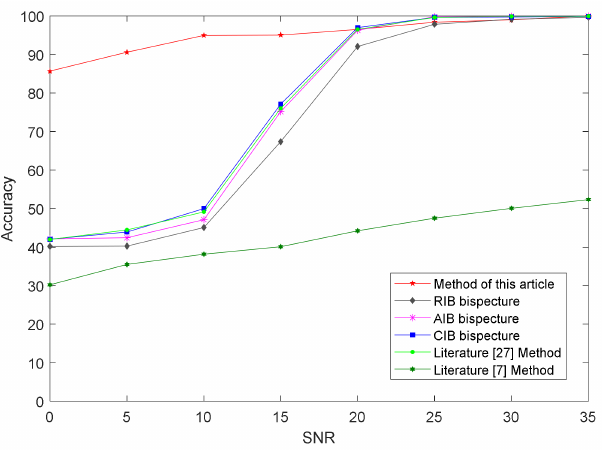
Figure 10. Recognition results of integral bispectrum algorithms, the algorithm in [27], and the proposed algorithm under different signal-to-noise ratio